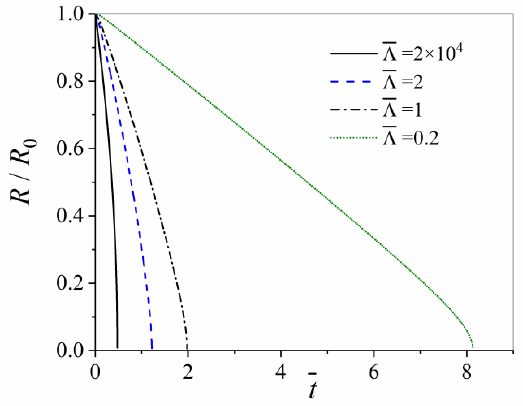
Figure 11. R / R 0 . is plotted versus normalized time t for different Λ